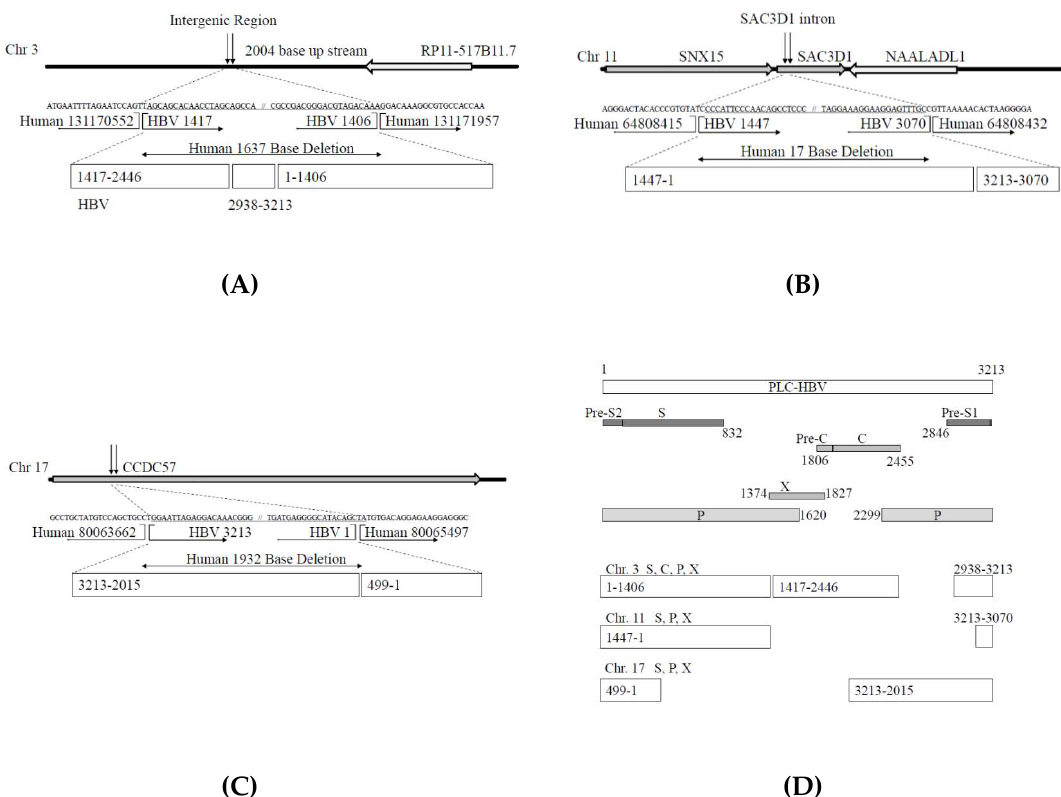
Figure 2. Results for integrated sequences of hepatitis B virus (HBV) and human genome chromosomes (Chrs) 3, 11, and 17 determined by Sanger sequencing. ( A ) Chr 3, ( B ) Chr 11, ( C ) Chr